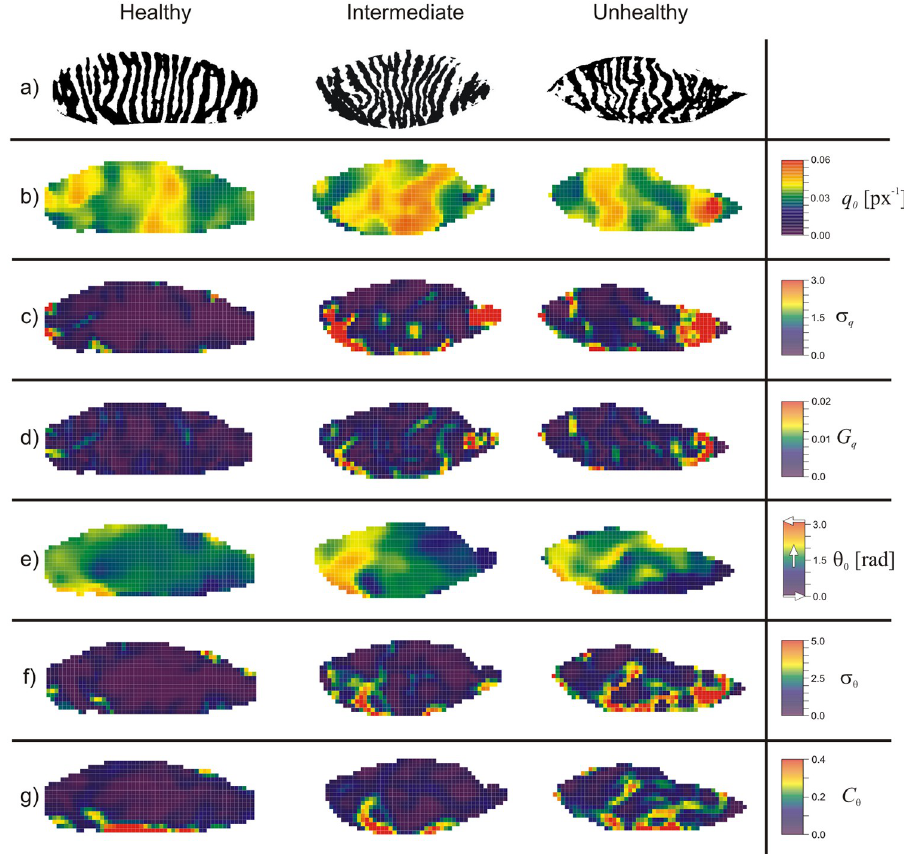
Fig 5. Six sets of morphometric maps calculated from three Meibomian images classified as healthy, intermediate and unhealthy (in columns). Subsequent rows show: a) original (binarized) Meibomian images; b) maps of gland frequency, q 0 ; c) maps of gland frequency variance, σ q ; d) maps of frequency gradient, G q .; e) maps of gland orientation, θ 0 ; f) maps of gland orientation variance, σ ; g) maps of angular incoherence, C θ θ